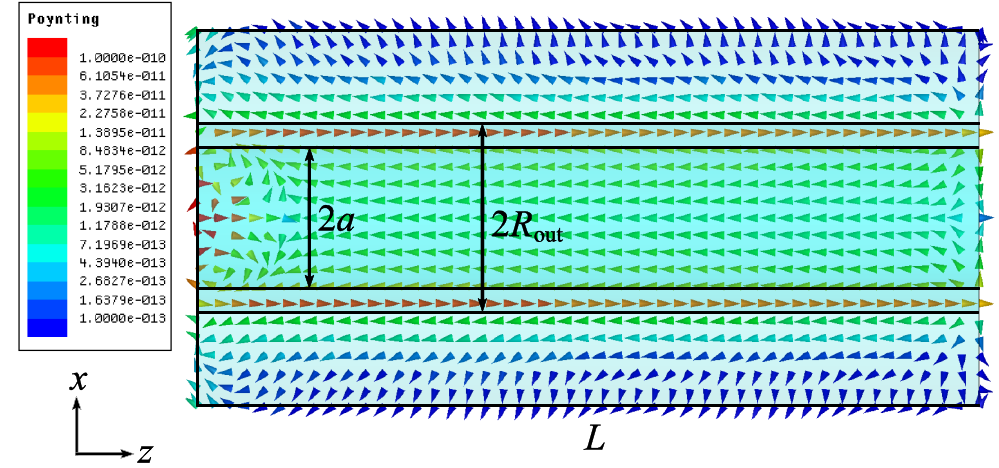
Figure 12. Time-averaged real part of the Poynting vector in the xz plane.